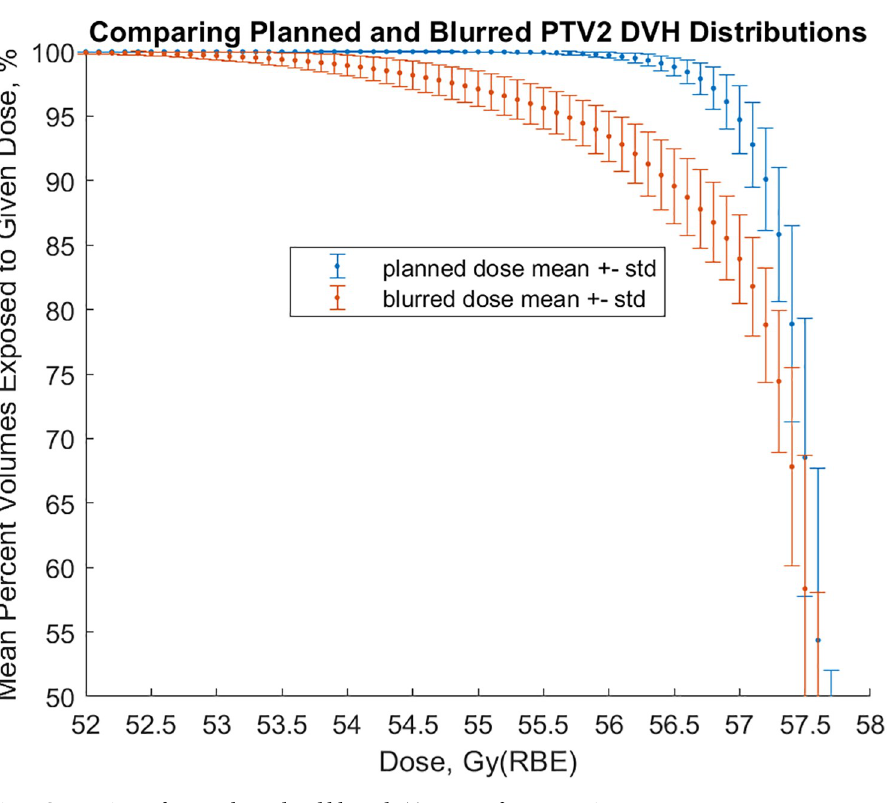
Fig 8. Comparison of mean planned and blurred PTV2 DVH from 40 patients.